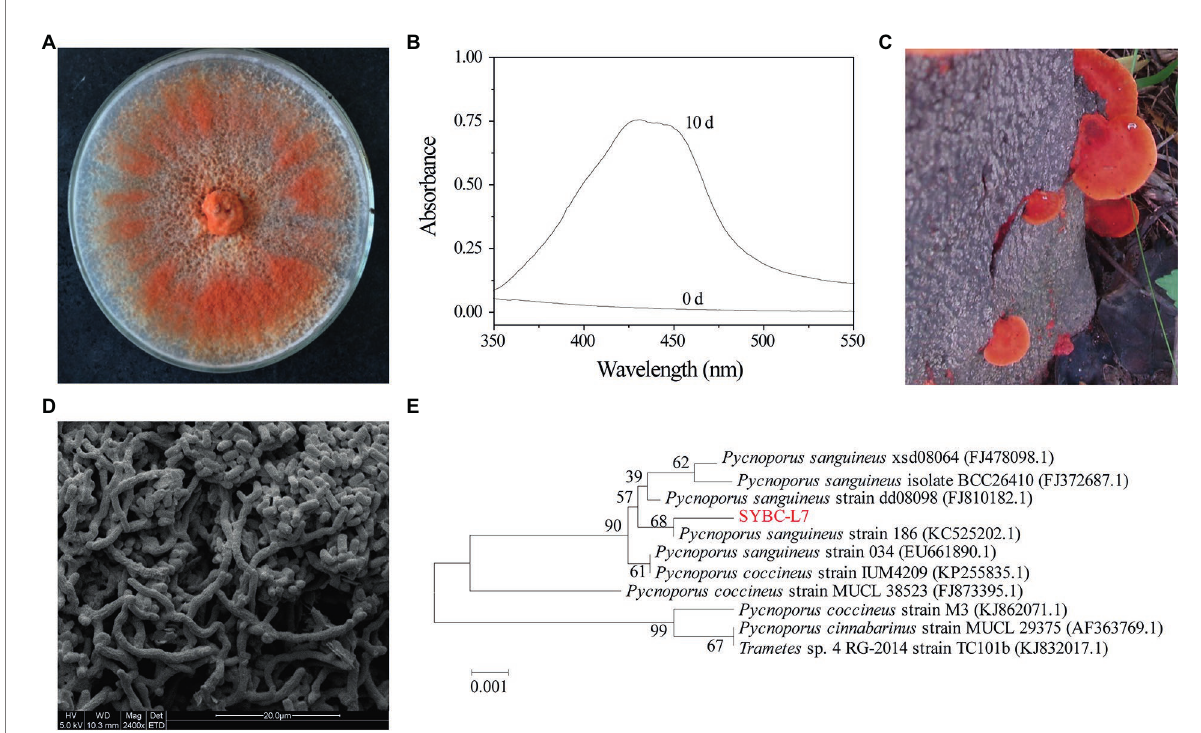
FIGURE 1 Orange pigment-producing fungal isolate (strain SYBC-L7) with the highest potency. (A) The mycelia of strain SYBC-L7 cultured on PDA medium for 9 d; (B) Spectral analysis of extract samples obtained from strain SYBC-L7 with wood chip for 10 d, and 0 d represent the unfermented solid substrate sample; (C) The fruit body of strain SYBC-L7; (D) Microscopic characteristics of the mycelia of strain SYBC-L7 cultured on PDA medium for 5 d; (E) Phylogenetic trees based on ITS-5.8S rRNA sequences of strain SYBC-L7 and others downloaded from NCBI.